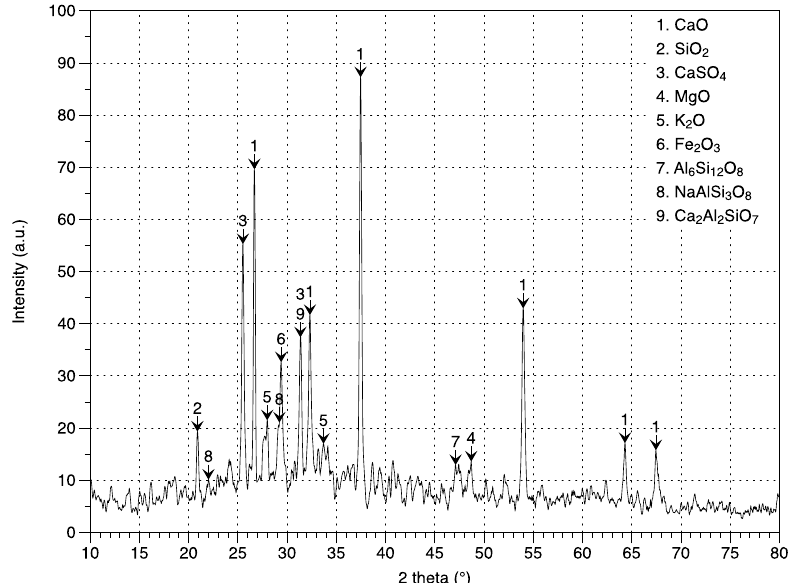
Figure 1. X-ray diffraction pattern of fly ash.